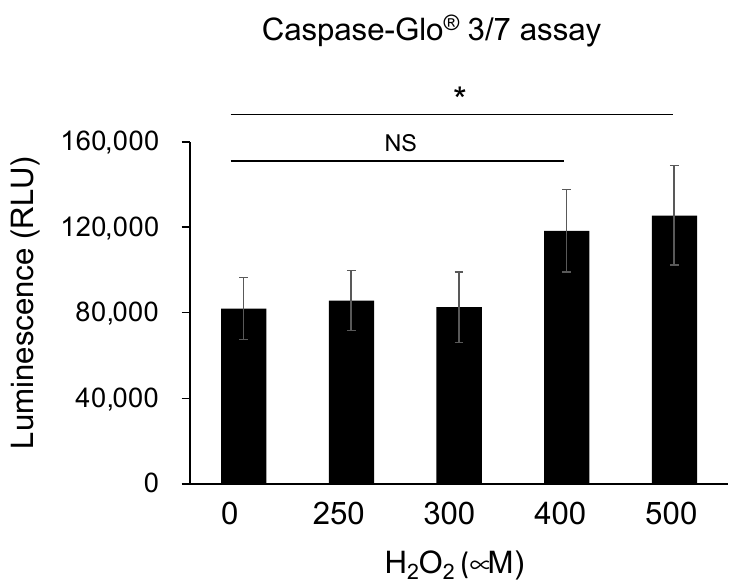
Figure 7. Apoptosis on trabecular meshwork cells by oxidative stress. Caspase 3/7 activation, which is a marker of apoptosis, in trabecular meshwork cells treated with various concentrations of H 2 O 2 (0, 250, 300, 400, 500 µ M) was determined by Caspase-Glo ® 3/7 assay. Caspase 3/7 activation on trabecular meshwork cells treated with 500 µ M H 2 O 2 was significantly increased compared to control (0 µ M H 2 O 2 ) ( n = 4 in each group, * p < 0.05). RLU, relative light units.